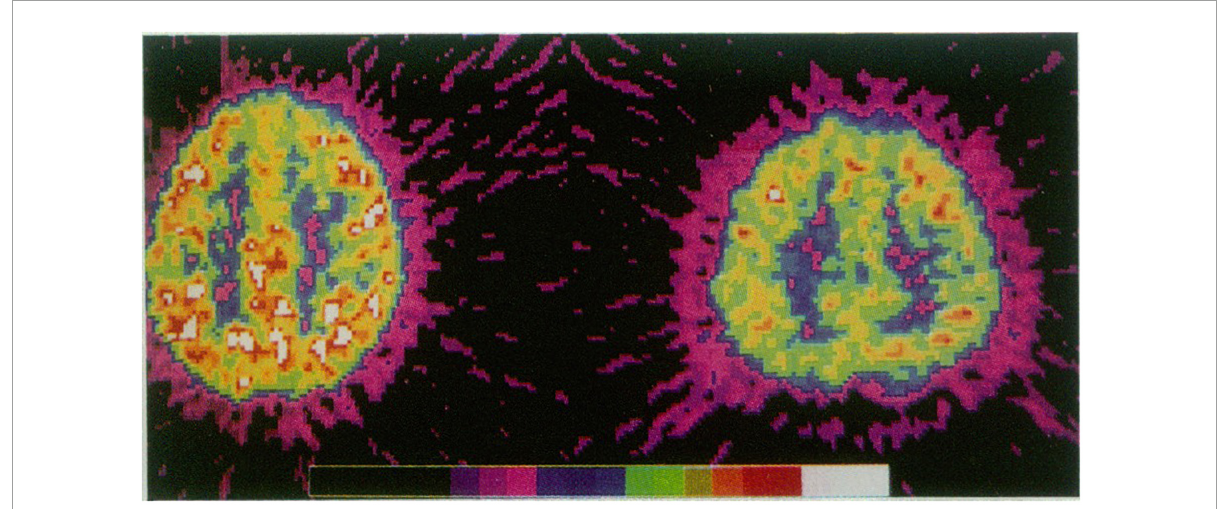
FIGURE1 Adapted from ref. (44) Copyright ©1990 of this illustration is retained by the Massachusetts Medical